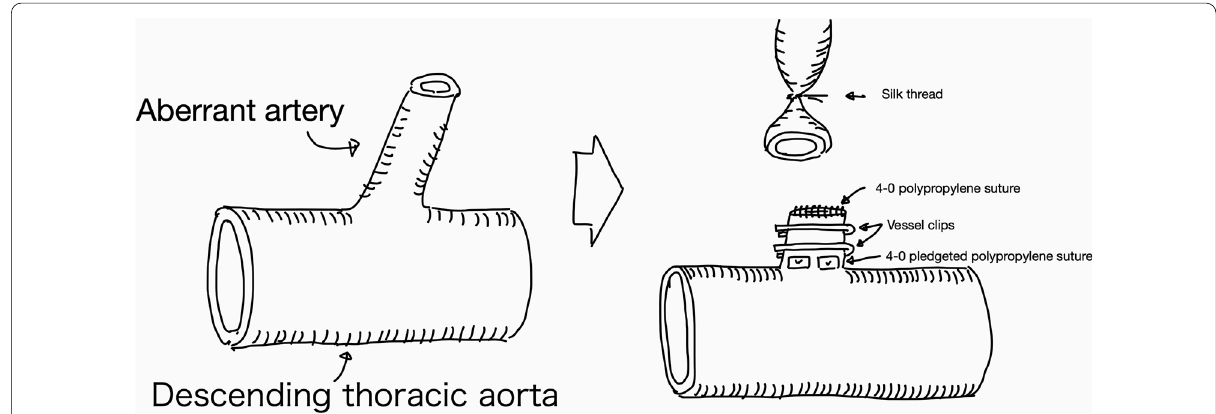
Fig. 5 Illustration of the treatment of the aberrant